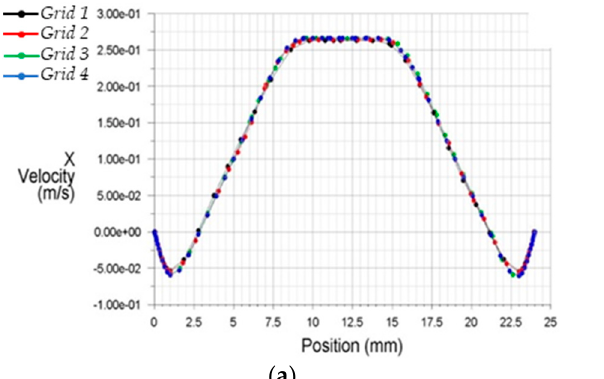
Table 1. Number of Elements and Nodes for the Tested Numerical Grids.